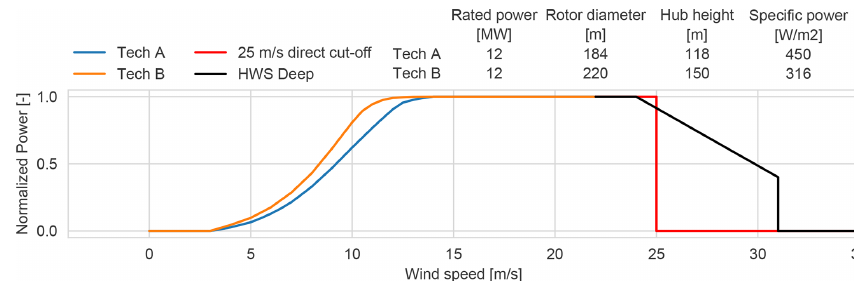
Figure 2. Power curves and technical parameters for assumed technology and storm shutdown